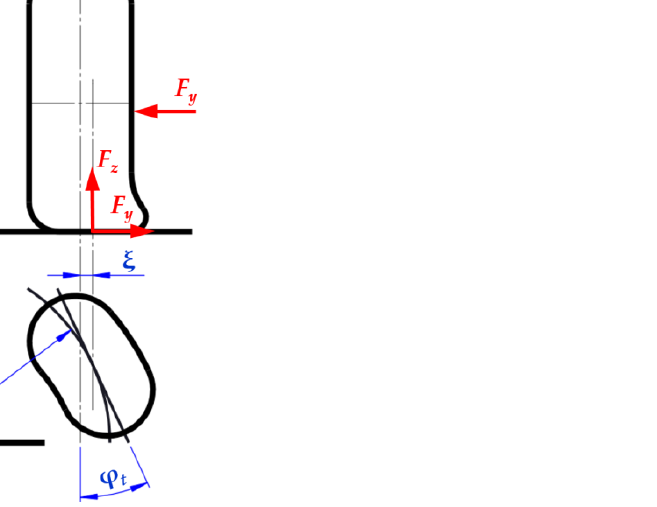
Figure 2. Tire deformation scheme in the presence of slip [48].